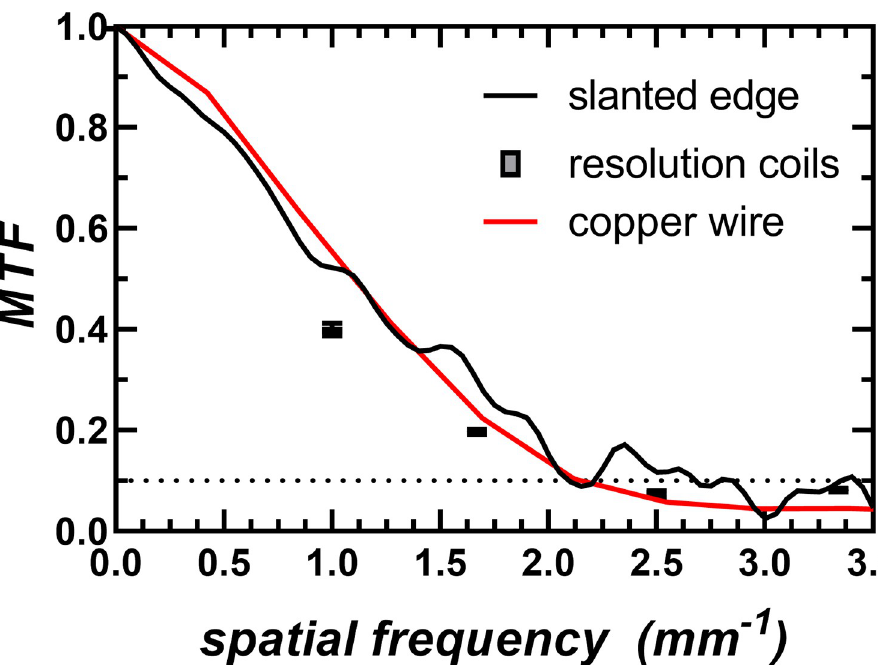
Fig 10. Modulation transfer function (MTF) of the cost-effective CT scanner measured from the slanted-edge plate, the resolution coil plate, and the copper wire of the CT quality assurance phantom. The 10% MTF level was reached at 2.12 mm -1 , corresponding to a spatial resolution of 235 μ